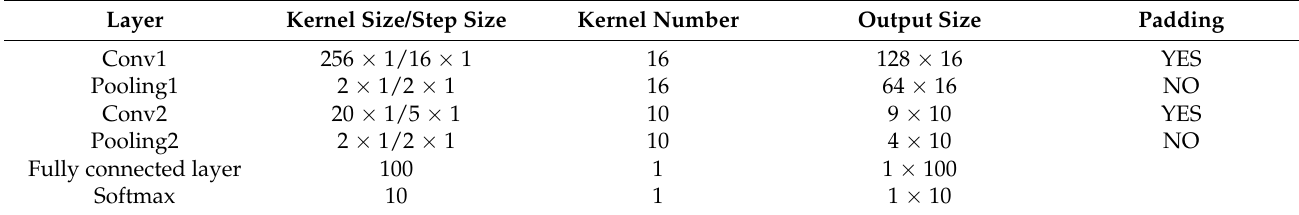
Table 1. Structures and parameters of